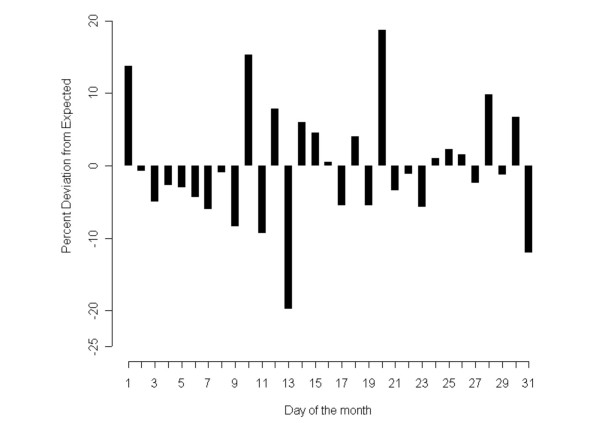
Digit preference for recall of cattle births using reported birth dates to BCMS and the percent of deviation from expected by day of the month after accounting for the different number of days in each month.